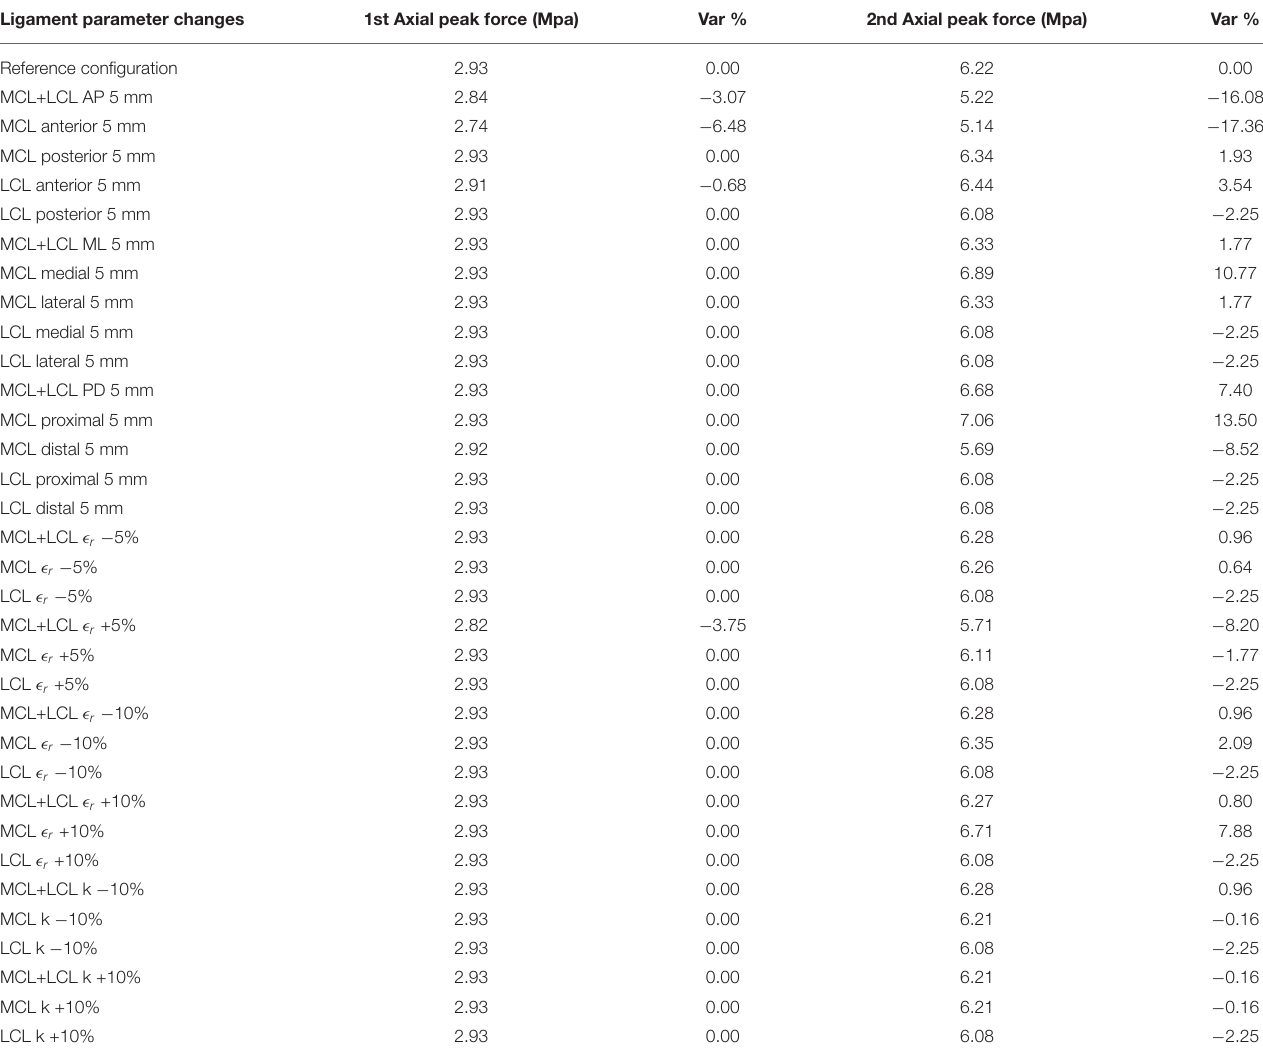
TABLE 2 | Maximum contact pressures at tibial insert after ligament parameter changes. Ligament parameter changes 1st Axial peak force (Mpa) Var % 2nd Axial peak force (Mpa) Var % Reference